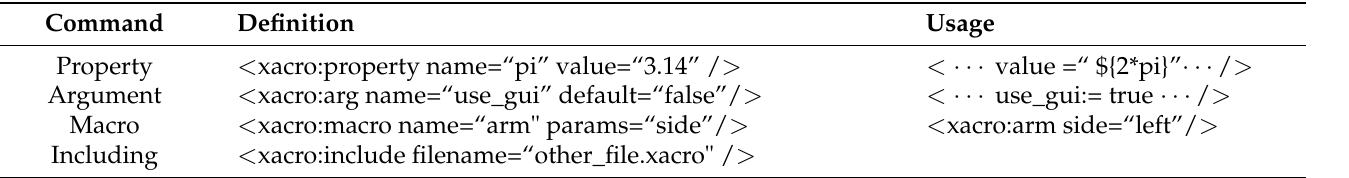
Table A1. Fundamental grammars of